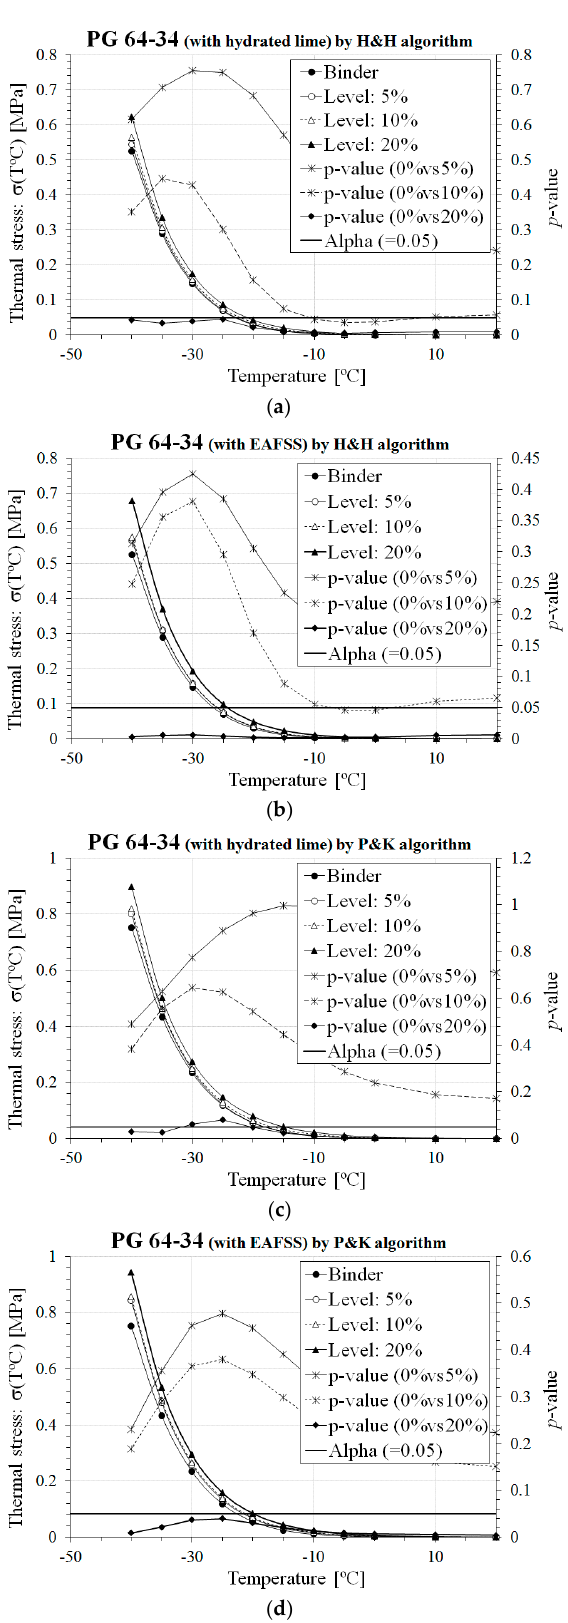
Figure 4. Comparison of σ ( T ) and T CR for PG 58-28 binder. ( a ) PG 58-28 (with hydrated lime) by H&H algorithm; ( b ) PG 58-28 (with EAFSS) by H&H algorithm; ( c ) PG 58-28 (with hydrated lime) by P&K algorithm; ( d ) PG 58-28 (with EAFSS) by P&K algorithm.